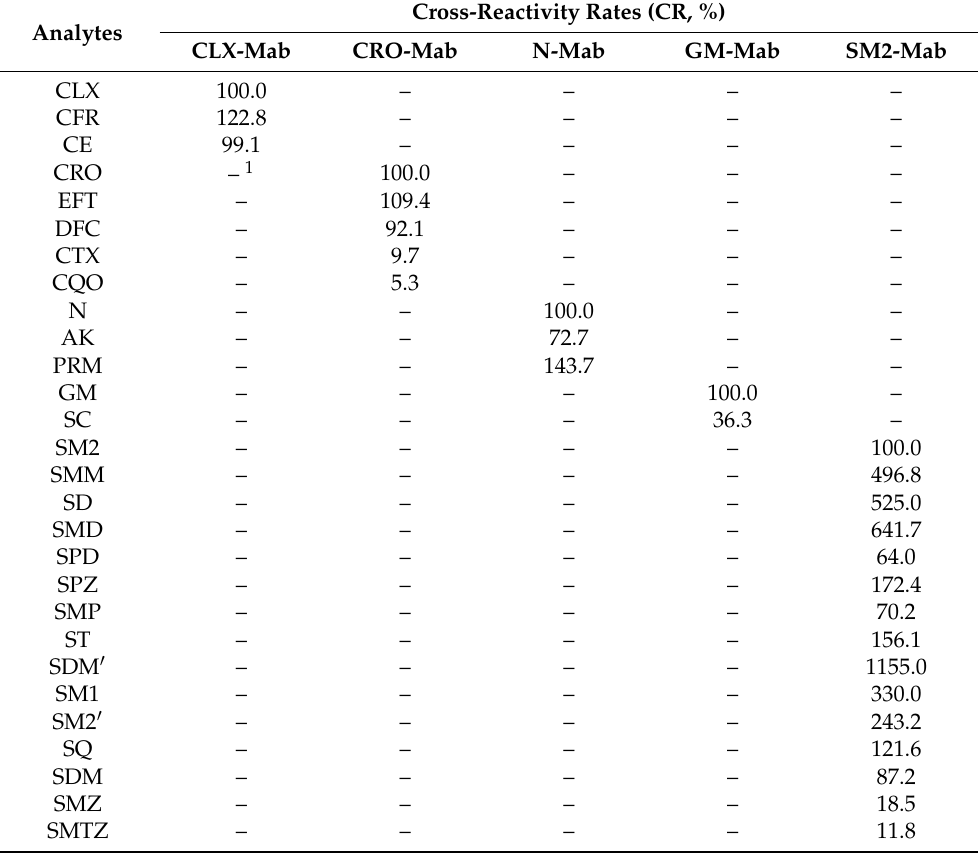
Table 3. The cross-reactivity rates of related analytes with the five mAbs.